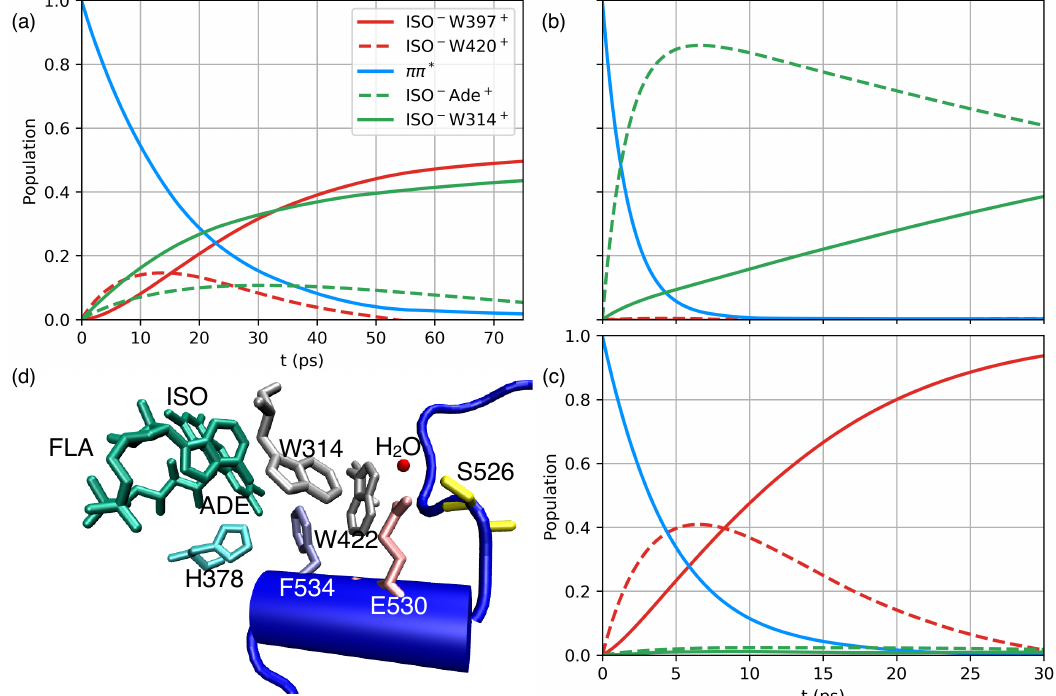
Figure 4. Nonequilibrium dissipative quantum dynamics of model (i)-wild-type dCRY ( a ), model (ii)-in silicio mutated R298 and E398 ( b ), and model (iii)-CTT-deficient dCRY ∆ [14] mimic ( c ) constructed upon neutralization of electrostatic interaction of photolyase homology region (PHR) and CTT domains; dynamics simulations were performed with the path-integral based MACGIC-QUAPI method [32], see Materials and Methods, Sections 4.4 and 4.5 for technical details. ( d ) Arrangement of FAD cofactor and tryptophan residues W314 and W422 together with residues of the CTT (F534, E530 and S526) and H378. The ππ ∗ → ISO − adenine (ADE) + → ISO − W314 + CT pathway relates CTT directional charge transfer dynamics to spatial vicinity of linear interaction motifs comprising E530 and S526 which are integrated into a hydrogen bond network with a crystal water, see text for